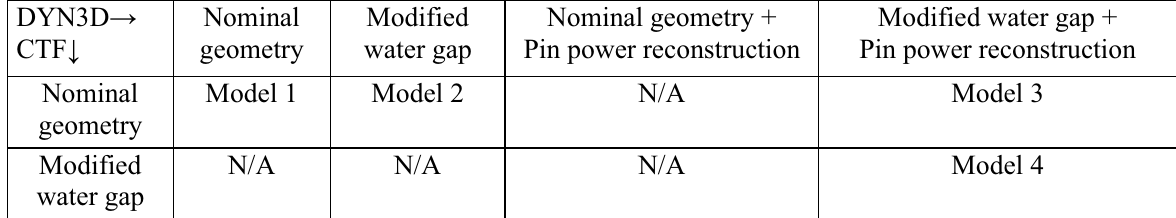
Table I. DYN3D-CTF Model